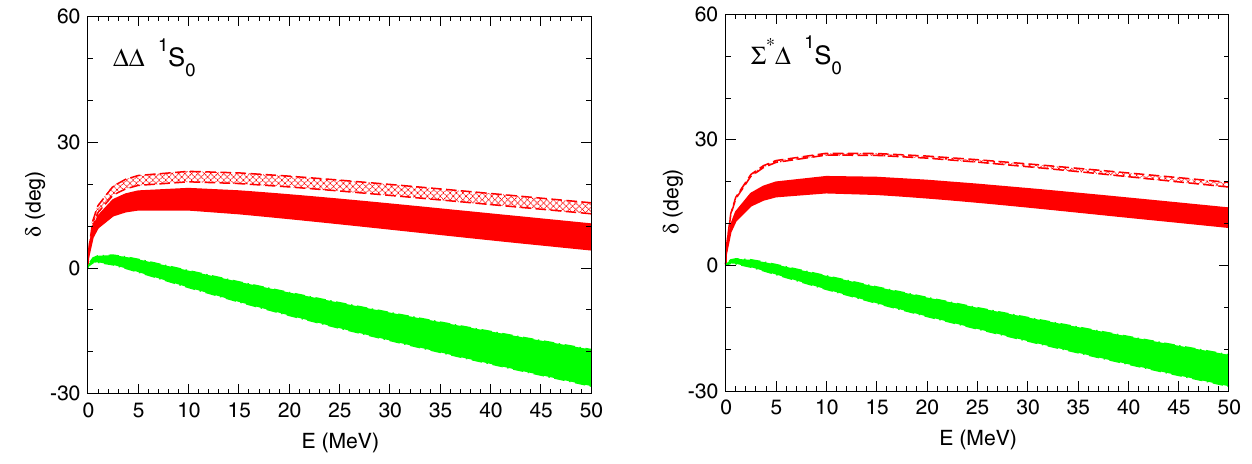
Fig. 3 Prediction for the Σ ∗ Δ 1 S 0 phase shift with isospin I = 5 / 2 based on the ΩΩ result and SU(3) symmetry. Same description of curves as in Fig. 2